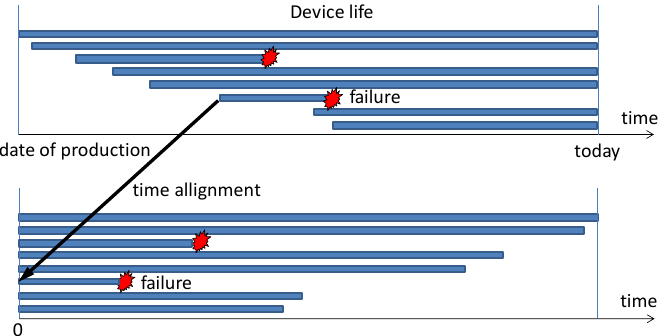
Figure 3. Date of production and failure ( top ), time alignment at the instant of production ( bottom ).